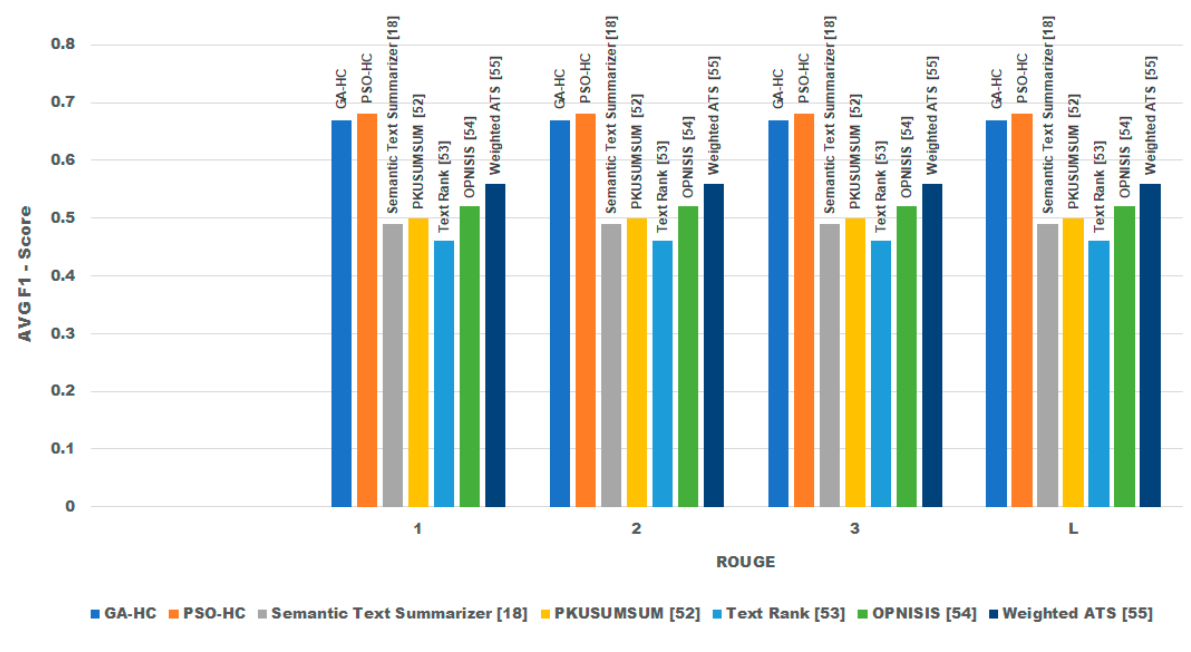
Figure 6. Comparison of various methods over CNN/daily mail dataset for average values of ( a ) precision, ( b ) recall, and ( c ) F1-score. Table 1. Genetic Algorithm (GA) with clustering techniques.